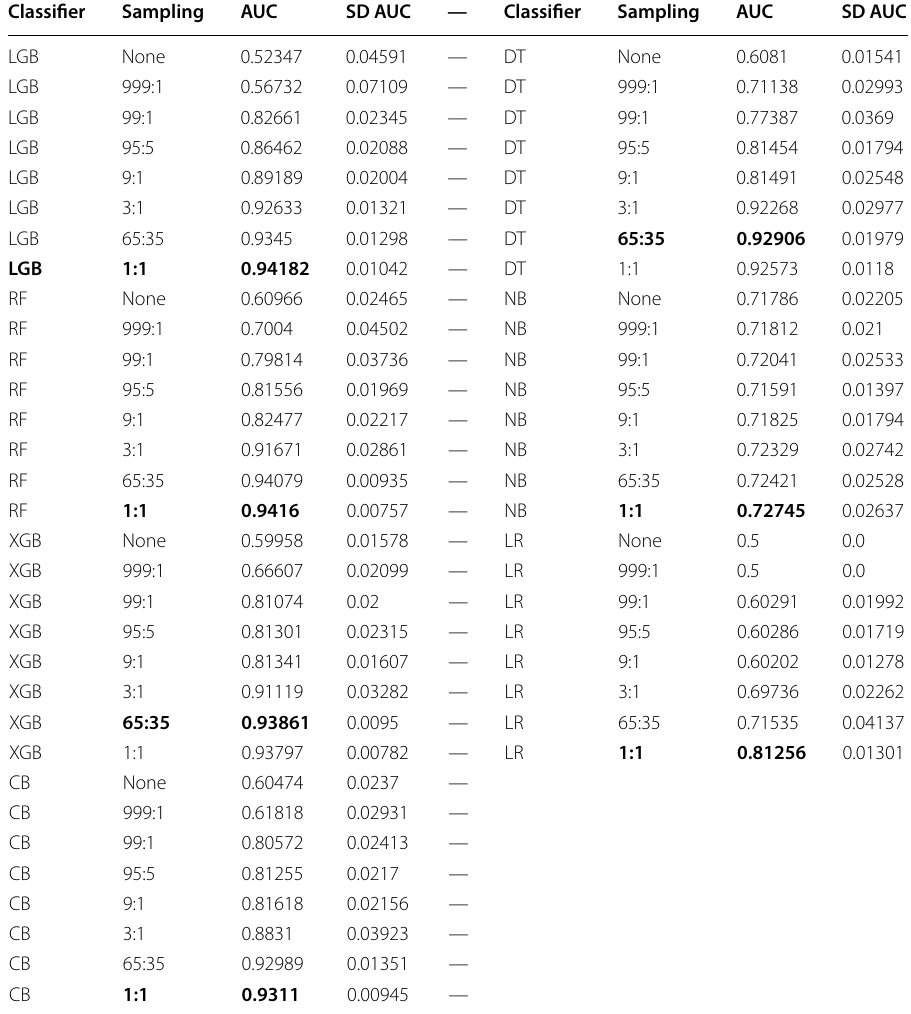
Bolded values indicate highest